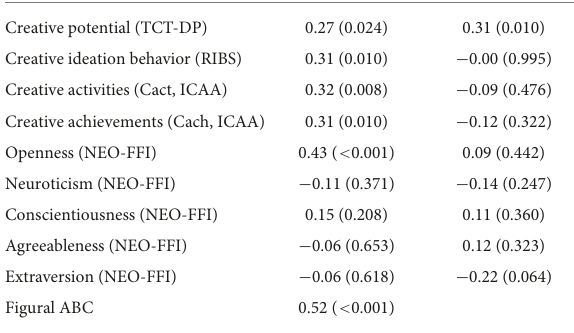
2 also predicted originality of the figural ABC, but not the group mean of the response time.